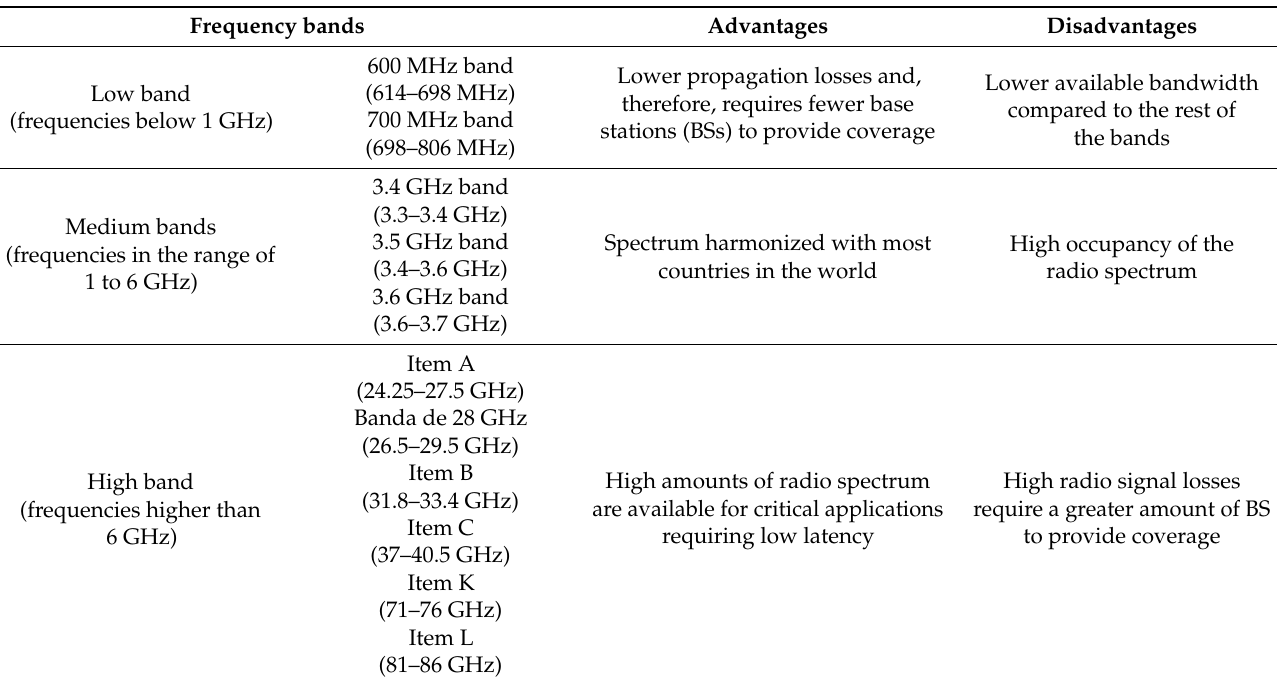
Table 4. Candidate frequency bands for 5G deployment in